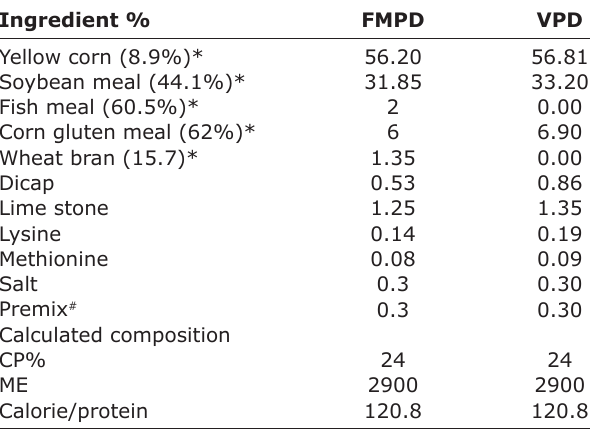
Table-2: Composition of isocaloric and isonitrogenous experimental diets. Ingredient %